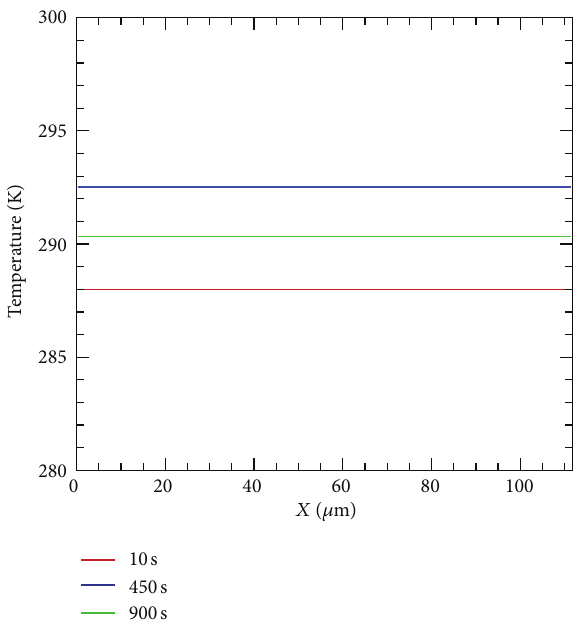
Figure 7: Spatiotemporal evolution of temperature within the battery under adiabatic conditions during a 15-minute hybrid drive